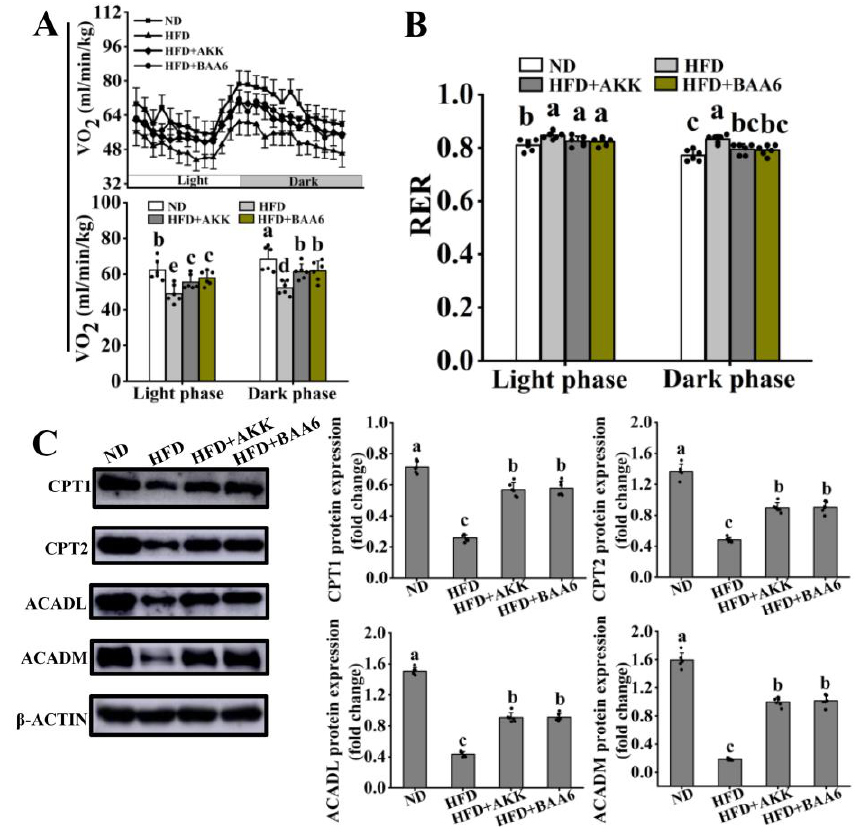
Figure 2. Effect of BAA6 on fatty acid β-oxidation (FAO) for epididymal adipose tissues in HFD-fed mice. ( A ) O 2 consumption and ( B ) respiratory exchange ratio (RER) were detected during a 12 h light/dark cycle in mice. ( C ) Expression levels of CPT1, CPT2, ACADL, and ACADM in epididymal adipose tissues were measured. Values are shown as means ± SD ( n = 6). Different lowercase letters mean remarkable differences between groups at p < 0.05. CPT1, carnitine palmitoyltransferase-1; CPT2, carnitine palmitoyltransferase-2; ACADL, long-chain acyl-CoA dehydrogenase; ACADM, medium-chain acyl-CoA dehydrogenase.